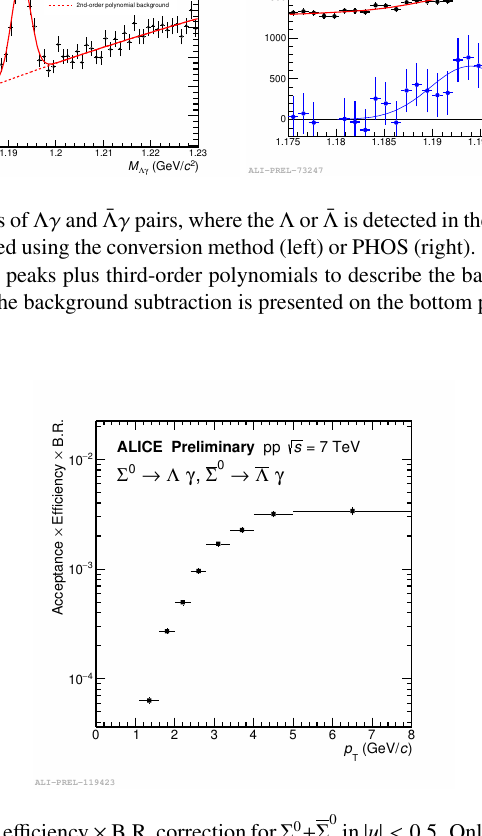
Figure 2. Acceptance are